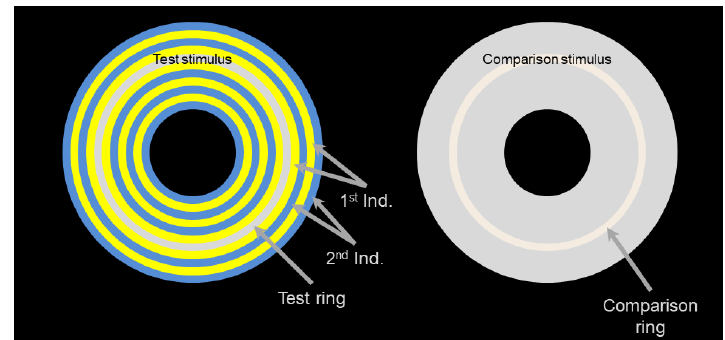
Figure 2. Spatial configuration of the stimuli with 11 stripes. Subjects had to adjust the colour of the comparison ring ( right ) to match the colour of the test ring ( left ). The whole stimulus subtended 17.3 × 13 degrees of visual angle. The test and the comparison rings had the same size (diameter of 6.91 degrees of visual angle) and their centres were separated by 8.68 degrees of visual angle. The configuration for the stimuli with 17 stripes was in all identical except that the concentric rings were thinner (width of 10.0 arcmin instead of 15.5 arcmin). The colours in the figure are illustrative. Full details on the colours used in the experiment are available in Table